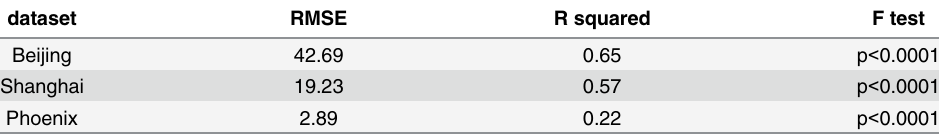
Table 1. Assessment of the support vector regression.